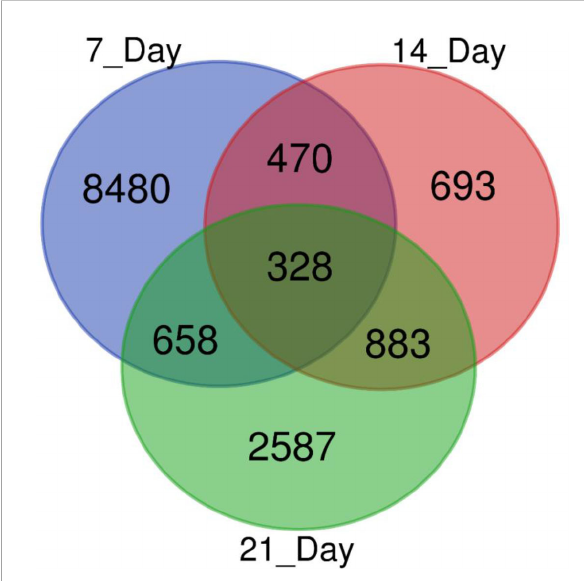
FIGURE 3 Venn diagram showing the number of DEGs obtained from different drought stress imposition periods in sugar